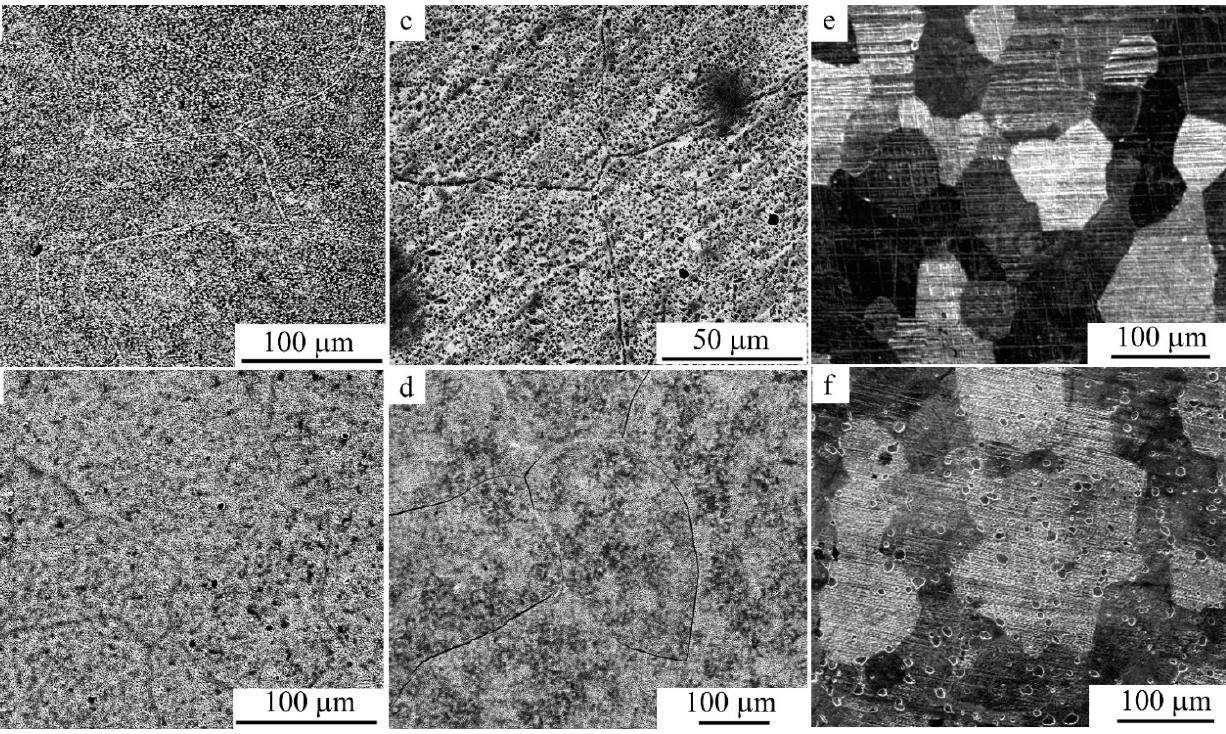
Figure 22. ( a – d ) SEM images in SE mode and ( e , f ) OM images of the FG structure in the Cu-14Al-4Ni alloy after the compression tests at ( a – c ) 673 K (( a )— v = 5, (b)— v = 1, ( c )— v = 0.5 mm/min), ( d ) 873 K ( v = 5 mm/min), ( e ) 973 K ( v = 1 mm/min), and ( f ) 1073 K ( v = 1 mm/min) [47].